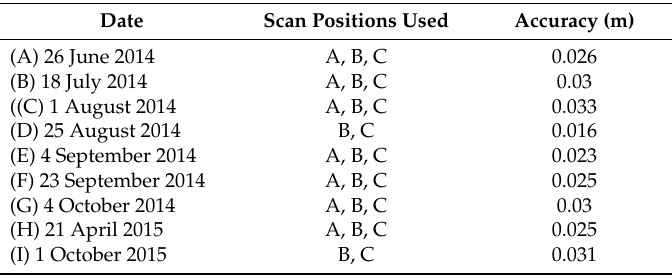
Table 3. Accuracy of each scan